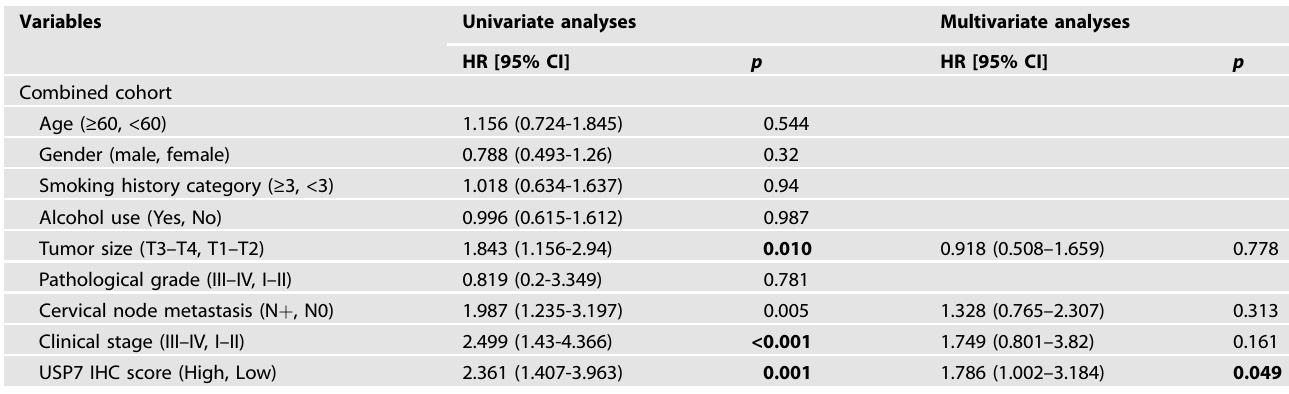
Univariate and multivariate survival analyses for patients with primary HNSCC. HR hazard ratio, CI con fi dence interval. Bold values indicates statistically signi fi cant at P < 0.05. Univariate and multivariate Cox regression analyses were used for calculating the USP7 IHC score in this research cohort. Differences were considered statistically (bold values) signi fi cant at P <